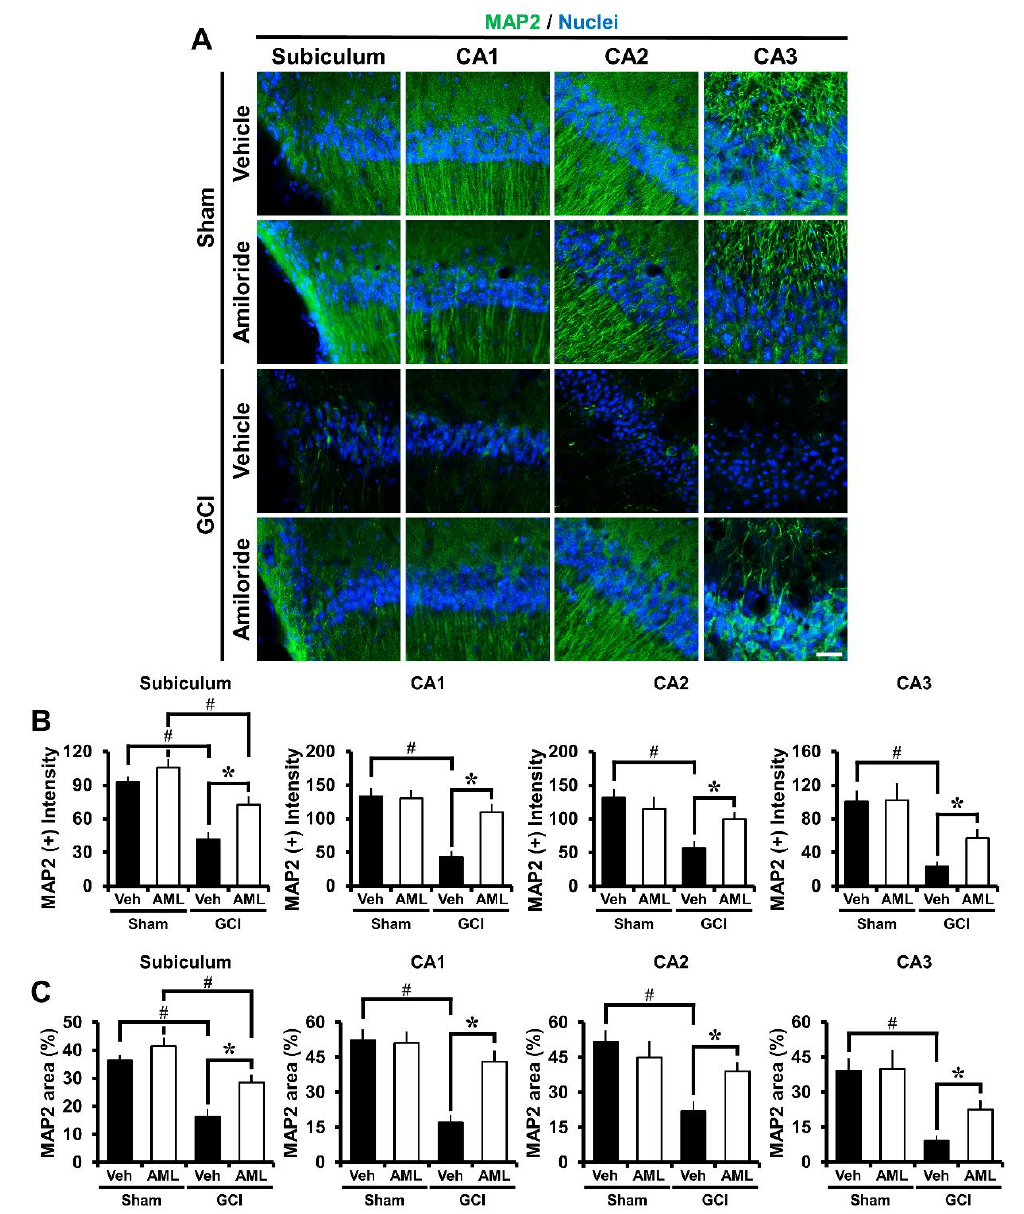
Figure 4. Microtubule damage was detected by microtubule-associated protein 2 (MAP2, green color) staining at the hippocampal Sub, CA1, CA2, and CA3 regions 24 h after GCI. ( A ) Sham-operated groups showed MAP2 fluorescence signals in the hippocampus. Amiloride-administered groups showed a reduced microtubule loss in the hippocampal regions compared with the vehicle-treated group. Scale bar = 20 µ m. ( B ) The bar graph indicates the MAP2 fluorescence intensity in the hippocampus. ( C ) The bar graph indicates the MAP2 percent area in the hippocampus (sham-vehicle, n = 6; sham-amiloride, n = 5; GCI-vehicle, n = 8; GCI-amiloride, n = 8). Data are mean ± S.E.M. * Considerably di ff erent from the vehicle-treated group, p < 0.05; # sham versus vehicle-operated group, sham versus vehicle-treated group, p < 0.05. (Kruskal–Wallis test (B) Sub: Chi square = 18.901, df = 3, p < 0.001; CA1: Chi square = 15.166, df = 3, p < 0.002; CA2: Chi square = 15.054, df = 3, p < 0.002; CA3: Chi square = 17.137, df = 3, p <